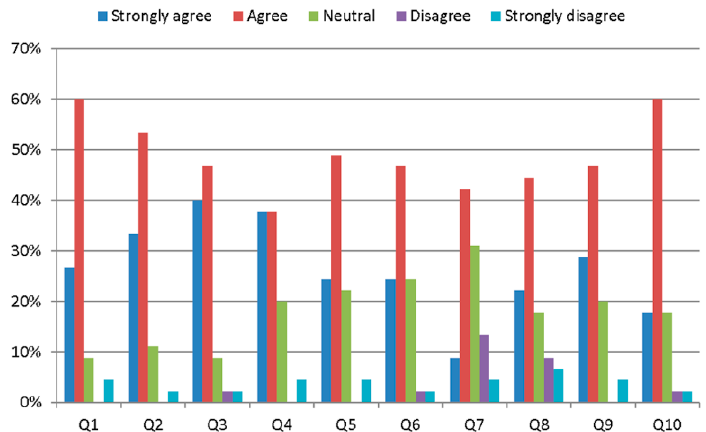
Figure 12. Students’ survey answers.